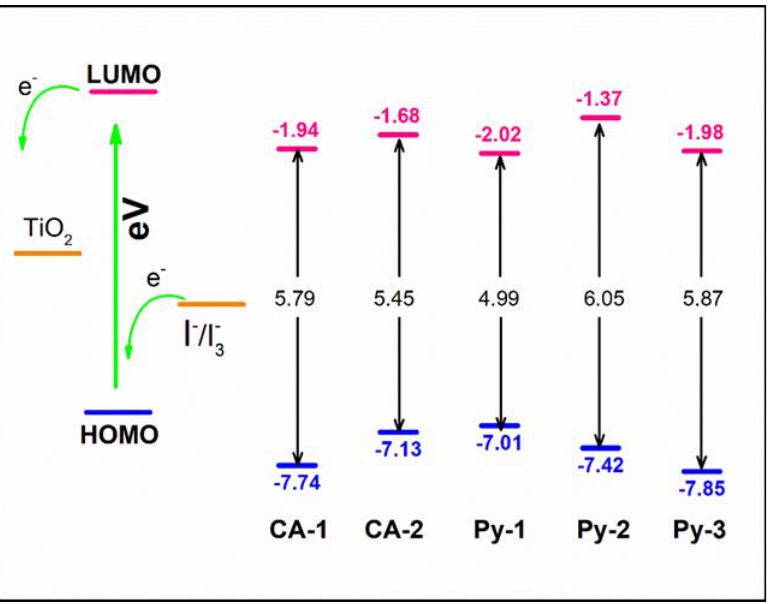
Figure 3. Energy level diagram of the HOMO and LUMO for all dyes, TiO2, and the electrolyte.